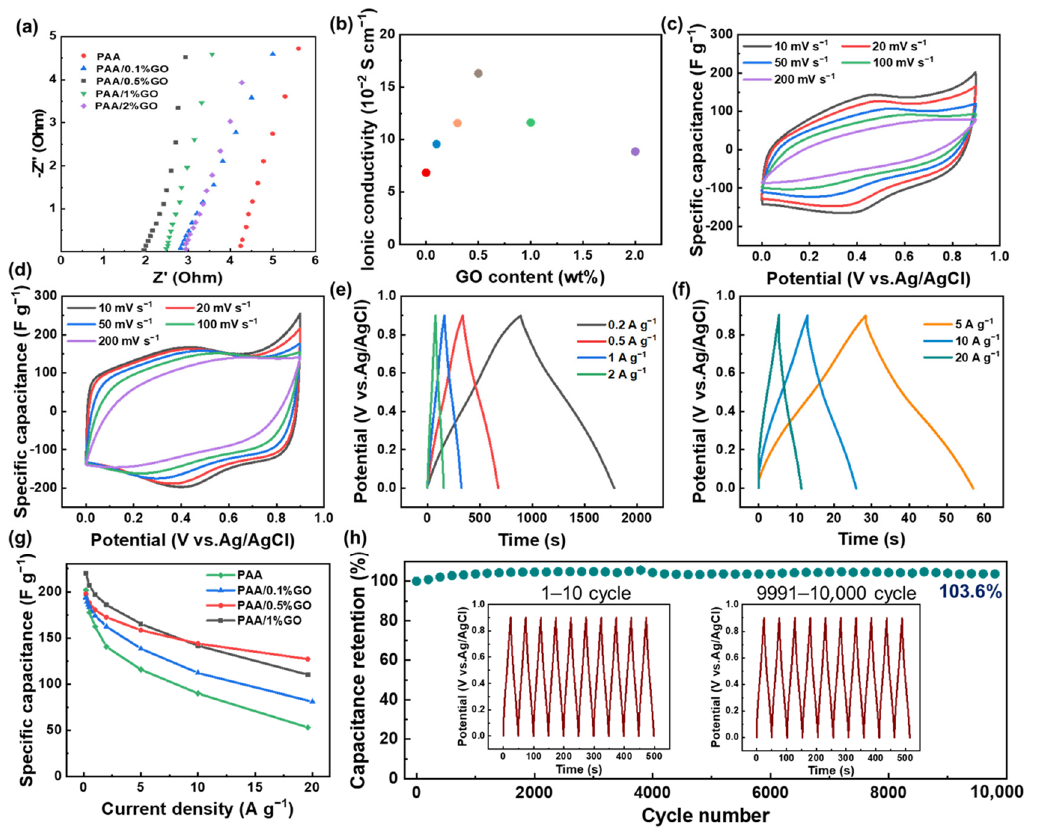
Figure 4. ( a ) Nyquist plots of PAA/GO electrolytes with different GO contents. ( b ) Ionic conductivity varies according to GO content. CV curves of the ( c ) PAA and ( d ) PAA/0.5%GO solid supercapacitor in 3 M H 2 SO 4 . ( e , f ) Galvanostatic charge–discharge curves at different current densities. ( g ) Specific capacitances as a function of current densities. ( h ) The cycling stability of PAA/0.5%GO at 5 A g − 1 for 10,000 cycles.